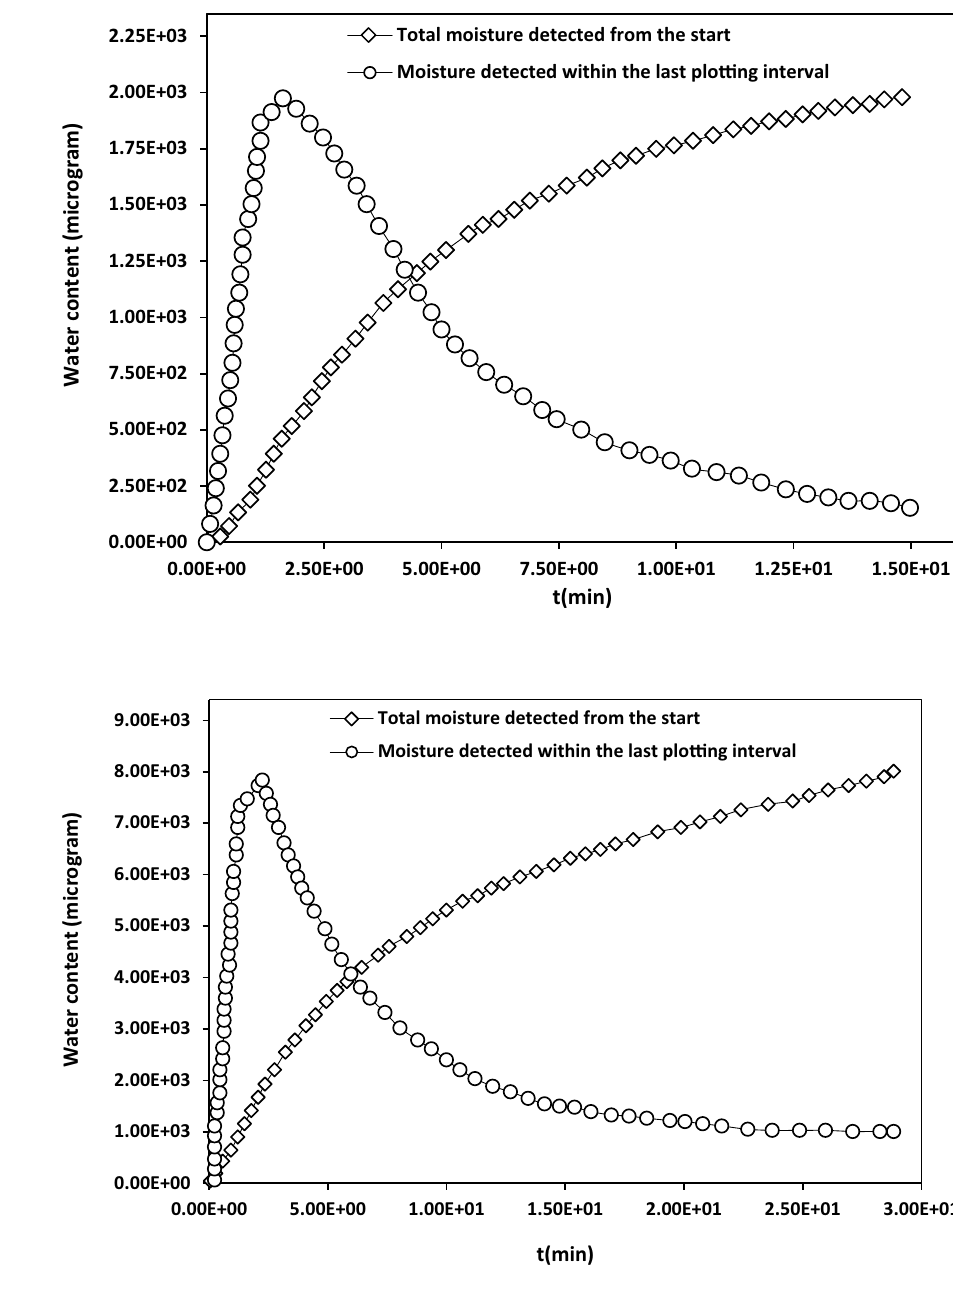
Fig. 7 Titration curve of the condensate sample